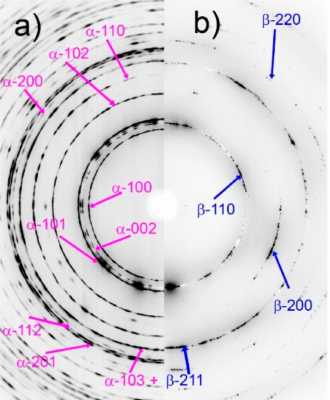
Figure 1. Half of the Debye-Scherrer rings showing some identified crystallographic planes of α and β phases ( a ) at room temperature and ( b ) at 1030 ◦